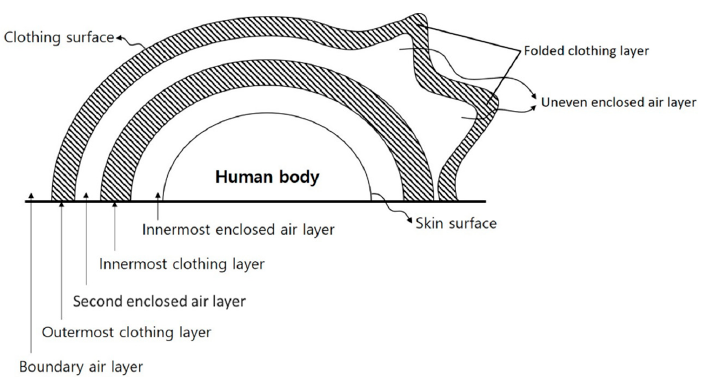
Figure 10. Clothing and air layers of the human body.